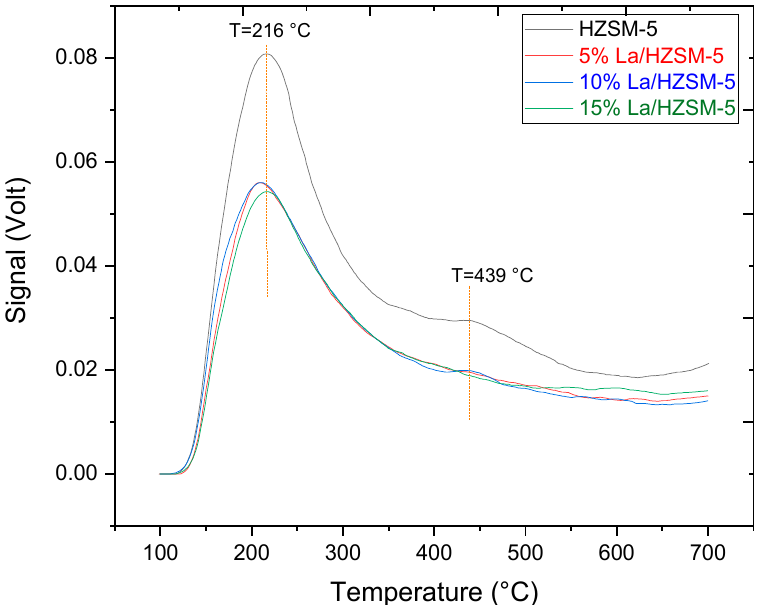
Figure 6. NH 3 -TPD profiles of the parent HZSM-5 and lanthanum-modified catalysts: 5%La/HZSM-5, 10%La/HZSM-5, and 15%La/HZSM-5.